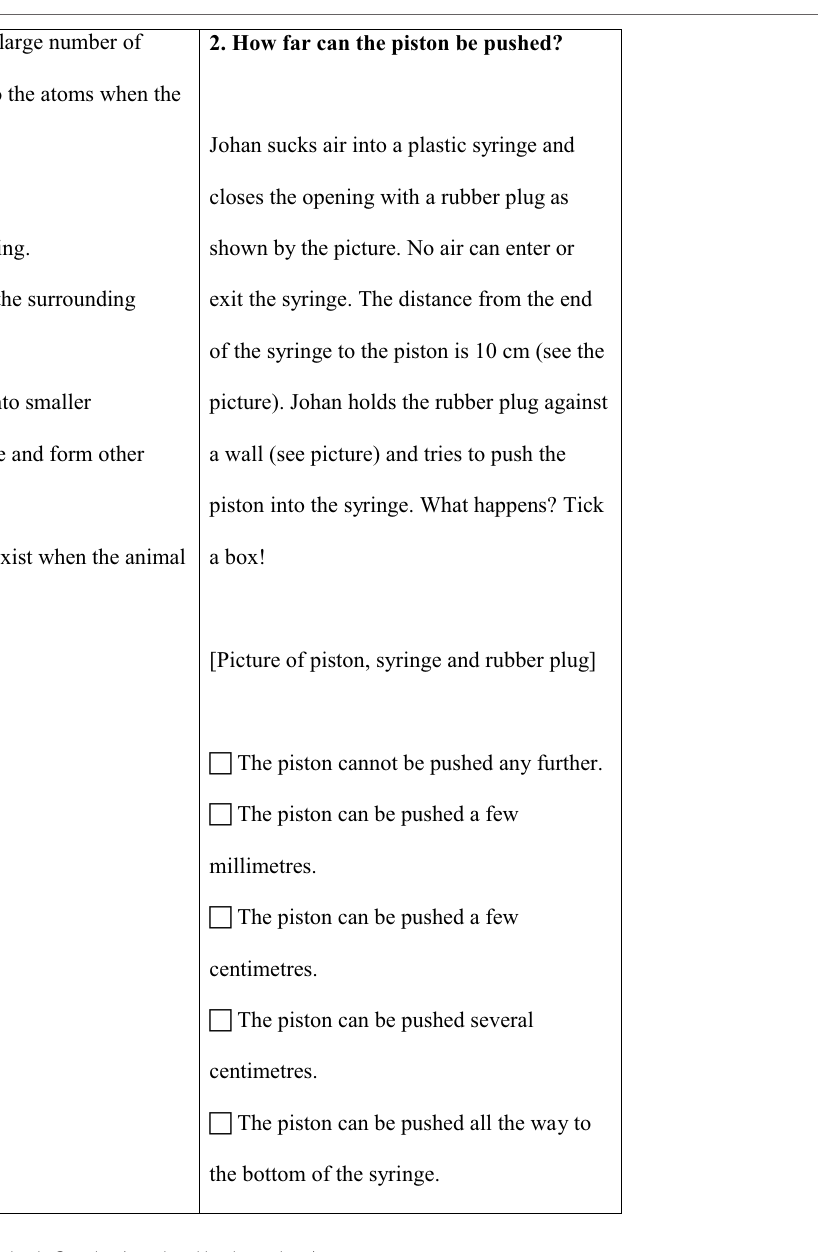
FigUre 1 | Multiple-choice items from a national evaluation in Sweden (translated by the